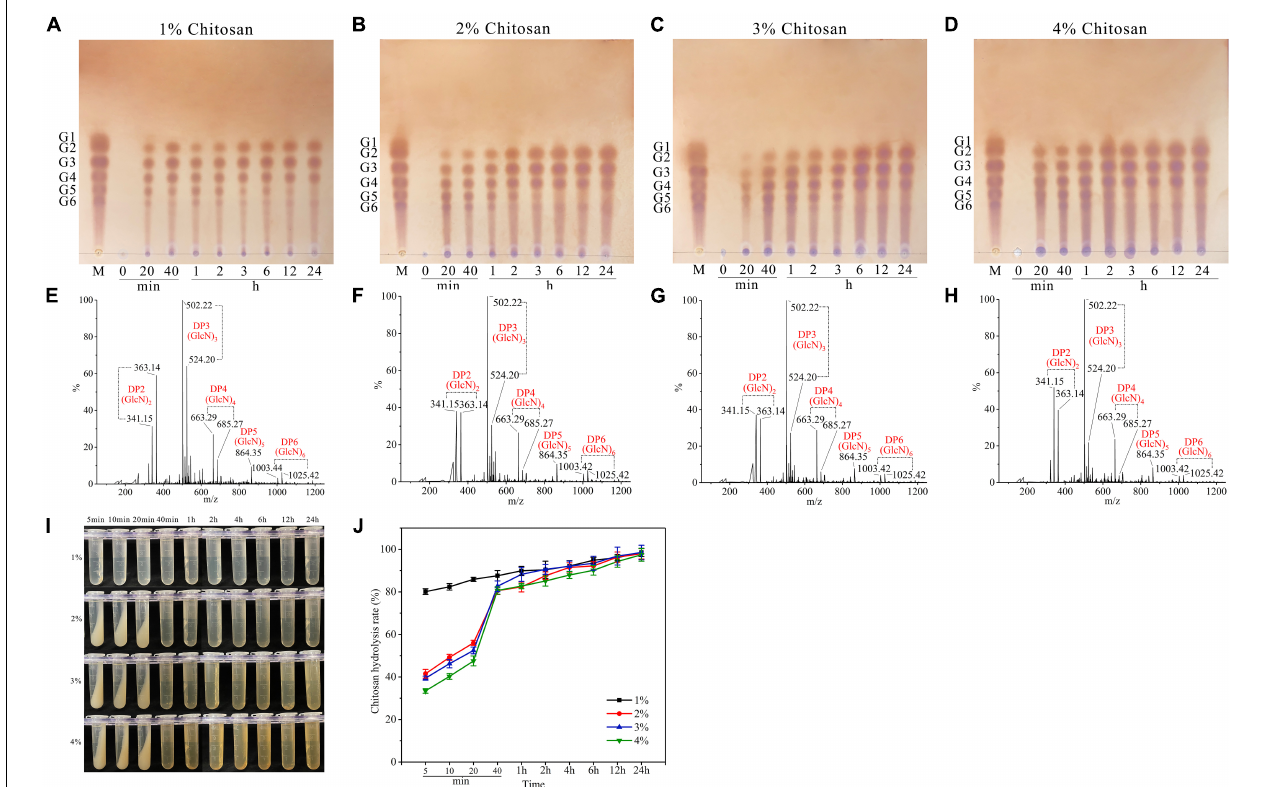
FIGURE 3 | TLC, ESI-MS analysis, and yield of chitosan hydrolysates prepared with Csn-SH. (A–D) TLC and ESI-MS analysis of 1–4% (wt/vol) chitosan hydrolysates for different reaction time, respectively. G1–G6 indicated (GlcN) 1 to (GlcN) 6 . Lane M: standard chitooligomers. Lanes 0–24: Chitosan hydrolysates prepared with Csn-SH incubated at 45 ◦ C for 20 min, 40 min, 1, 2, 3, 6, 12, and 24 h, respectively. (E–H) ESI-MS analysis of 1–4% chitosan hydrolysates prepared with Csn-SH at 45 ◦ C for 24 h, respectively. (I) The precipitation of undegraded chitosan with 20 U/mL crude Csn-SH at different reaction time. (J) The hydrolysis rates of 1–4% chitosan by Csn-SH at different reaction time with 20 U/mL crude Csn-SH.